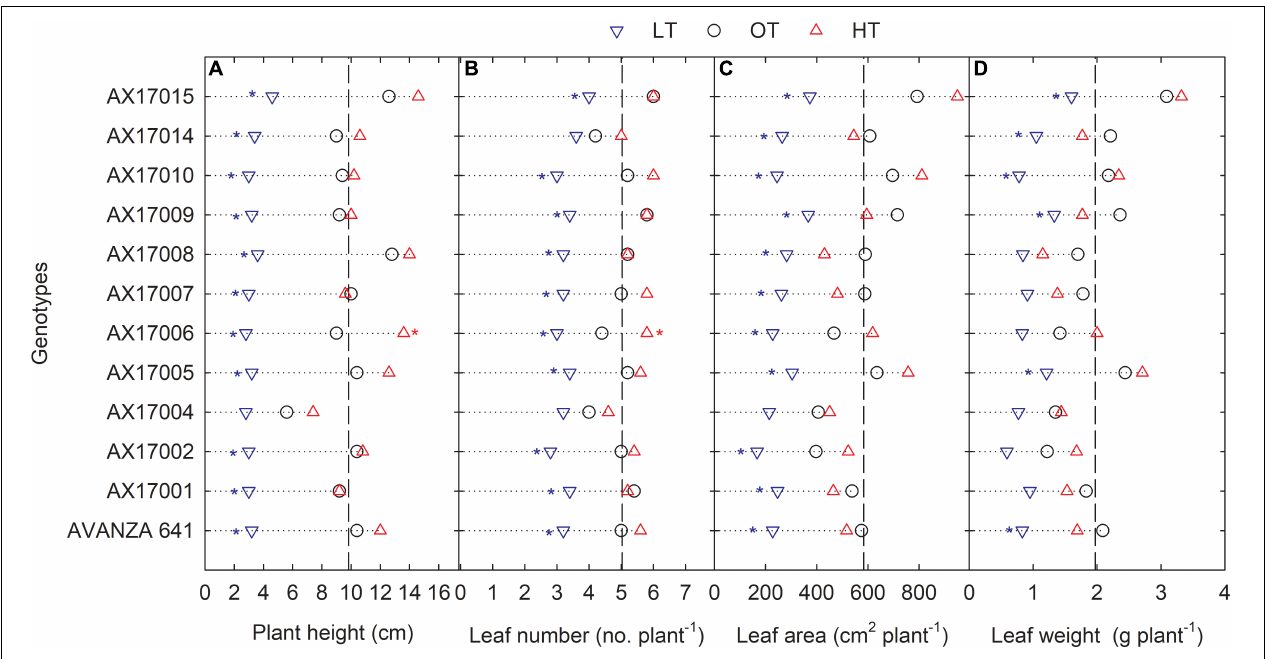
FIGURE 2 | Line plots showing the phenotypic variations of shoot-related traits such as plant height (A) , number of leaves (B) , leaf area (C) , and leaf weight (D) of 12 advanced Brassica carinata genotypes measured 35 days after planting or 24 days after temperature treatments imposition. The dotted middle line indicates the average trait of 12 genotypes under optimum temperature. LT, low temperature; OT, optimum temperature; and HT, high temperature. Asterisk indicates a significant difference between the temperature treatments (blue – between LT and OT; red – between HT and OT) in a genotype at 5% LSD.